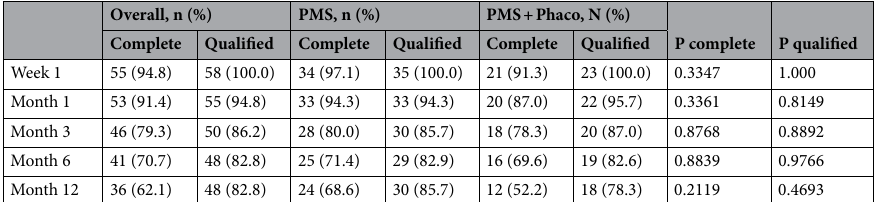
Overall, n (%) PMS, n (%) PMS + Phaco, N